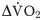
HIIT physiological responses from two representative participants are reported for: ΔV˙O2 (Panel A), HR (Panel B), and TSI (Panel C). Example of a participant able to complete a higher number of HIIT repetitions (in grey); dark traces represent a subject with lower tolerance to HIIT. Horizontal continuous lines represent the maximal values for the respective physiological parameters reached at the end of the INC test. HIIT: high-intensity interval testing, INC: maximal incremental exercise test, V˙O2: oxygen consumption, TSIINC: nadir of tissue saturation index during INC.